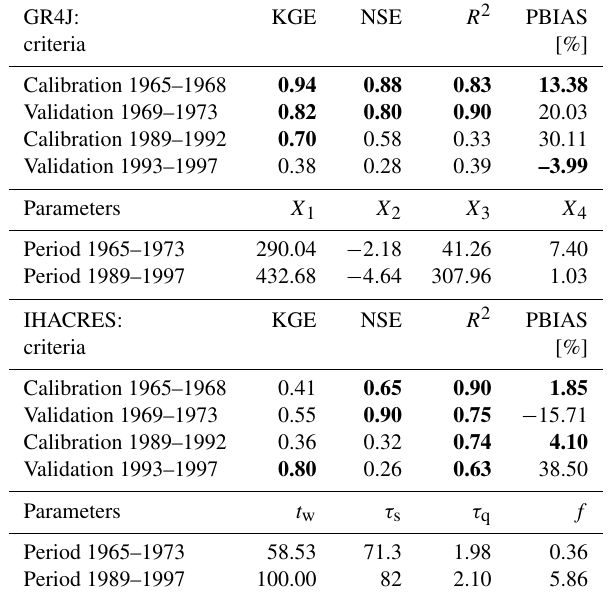
Table 2. Model’s performance – uncertainty and optimized param- eters. Acceptable performance values are in bold.